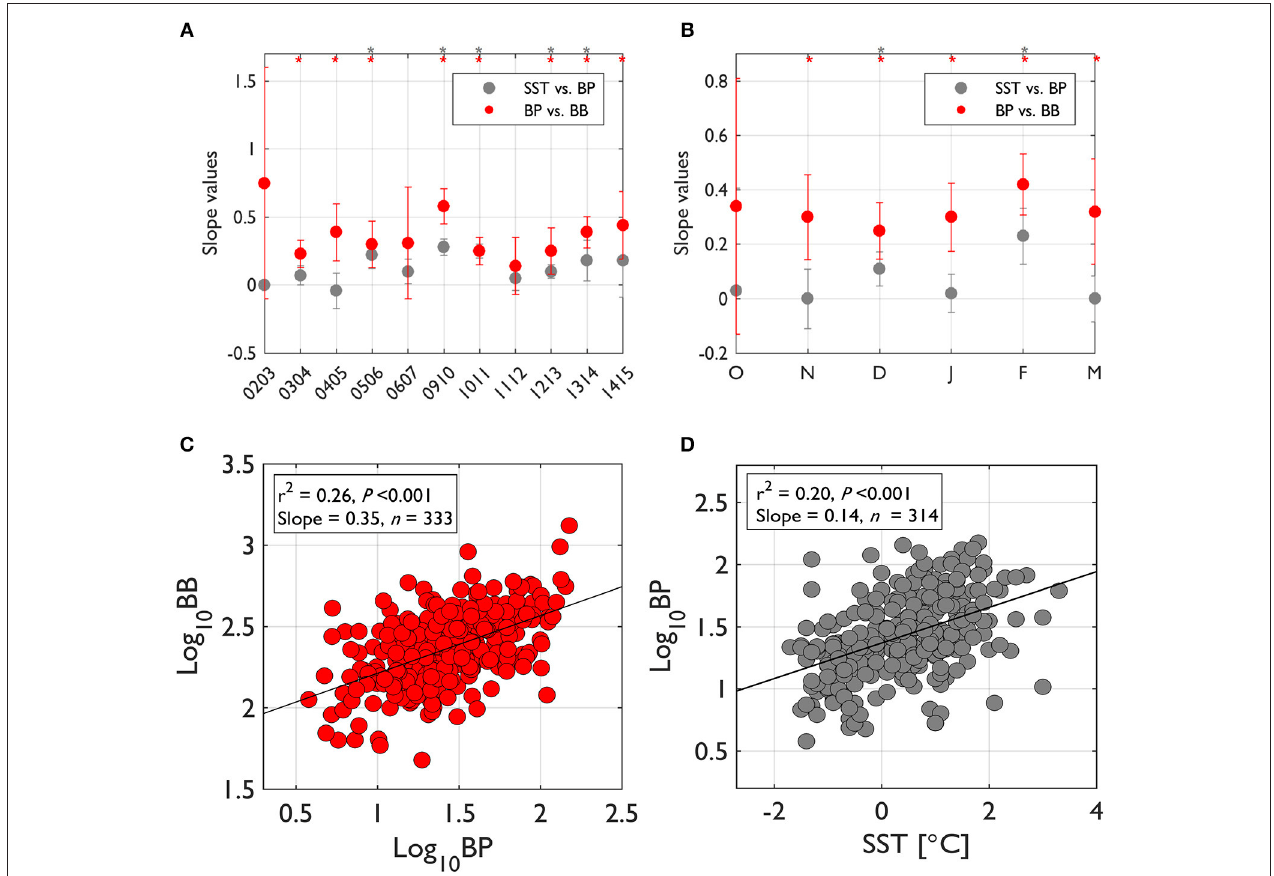
FIGURE 3 | The degree of bottom-up control on bacterial biomass (BB) and of temperature control on bacterial production (BP) based on the slope values from log-log regressions of BP-BB and of sea surface temperature (SST)-BP. The degree of bottom-up control on BB and of temperature control on BP were examined from regression slope values between those variables (asterisk on top of plot indicates significant regressions at P < 0.05). For each year’s slope values (A) , the slope values for that year were calculated by pooling all seasonal months’ data in that particular year. For seasonal slope values (B) , the slope values for each month were calculated by pooling all individual years’ data in that particular month. When pooled for all seasons and years (C,D) , the regression slope value for BP-BB was 0.35 ( r 2 = 0.26, P < 0.001, n = 333) and the regression slope value for SST-BP was 0.14 ( r 2 = 0.20, P < 0.001, n = 314). Error bars indicate standard deviation of the slope value at 95% Confidence Interval